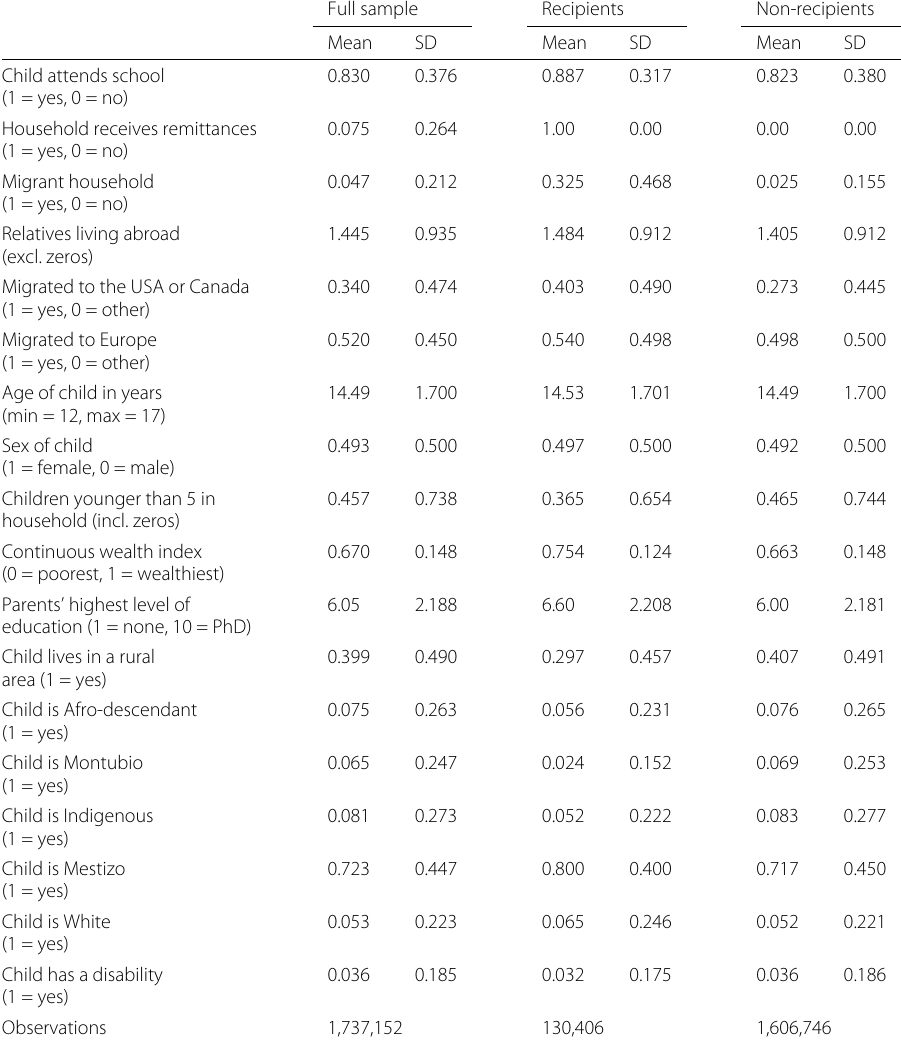
Table 1 Descriptive statistics by household remittance reception status Full sample Recipients Non-recipients Mean SD